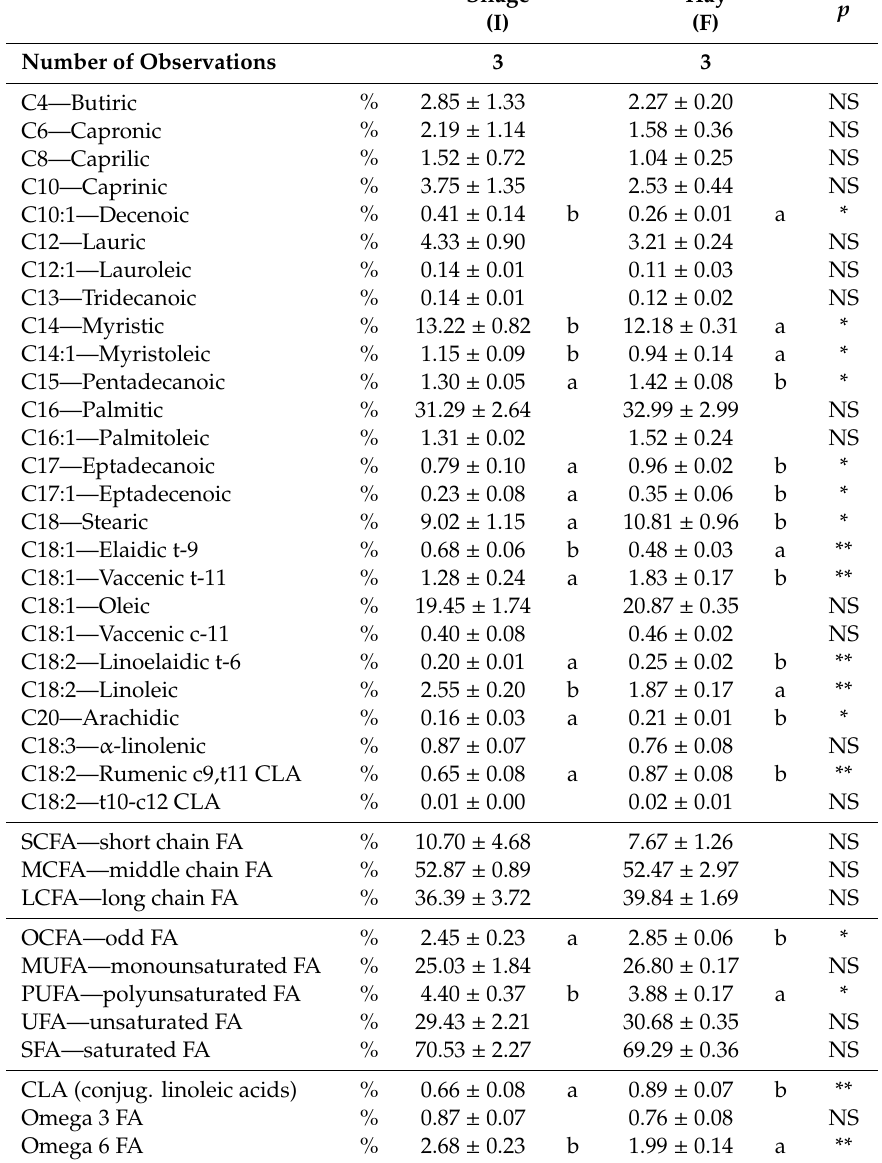
Table 3. Percentage distribution of the fatty acids of the cheese at 30 days ripening relative to the comparison of the winter period between milk produced from cows fed silage and milk produced from cows fed hay. Mean ± SD. a, b, di ff er for p < 0.05. NS, p > 0.05; * p ≤ 0.05; ** p ≤